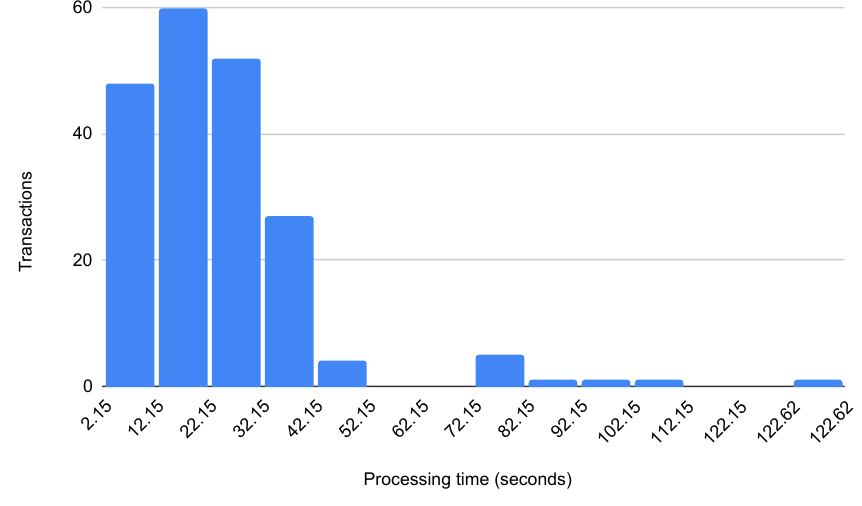
Figure 5. Distribution of the processing times on a public blockchain (expressed in